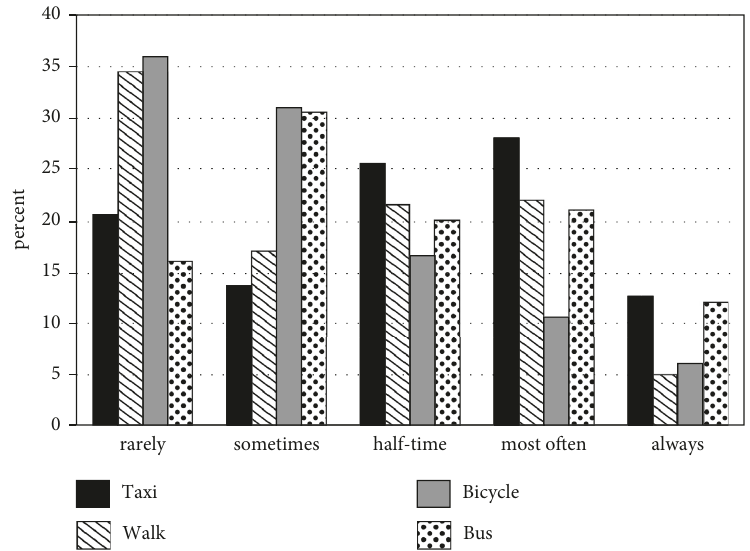
Figure 2: Different transportation modes